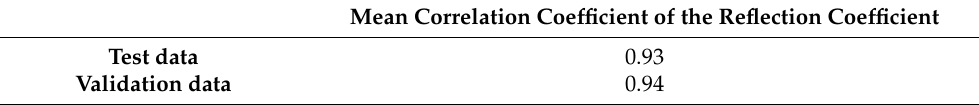
Table 5. Mean correlation coefficient results of Model-2 and simulation based on test data.